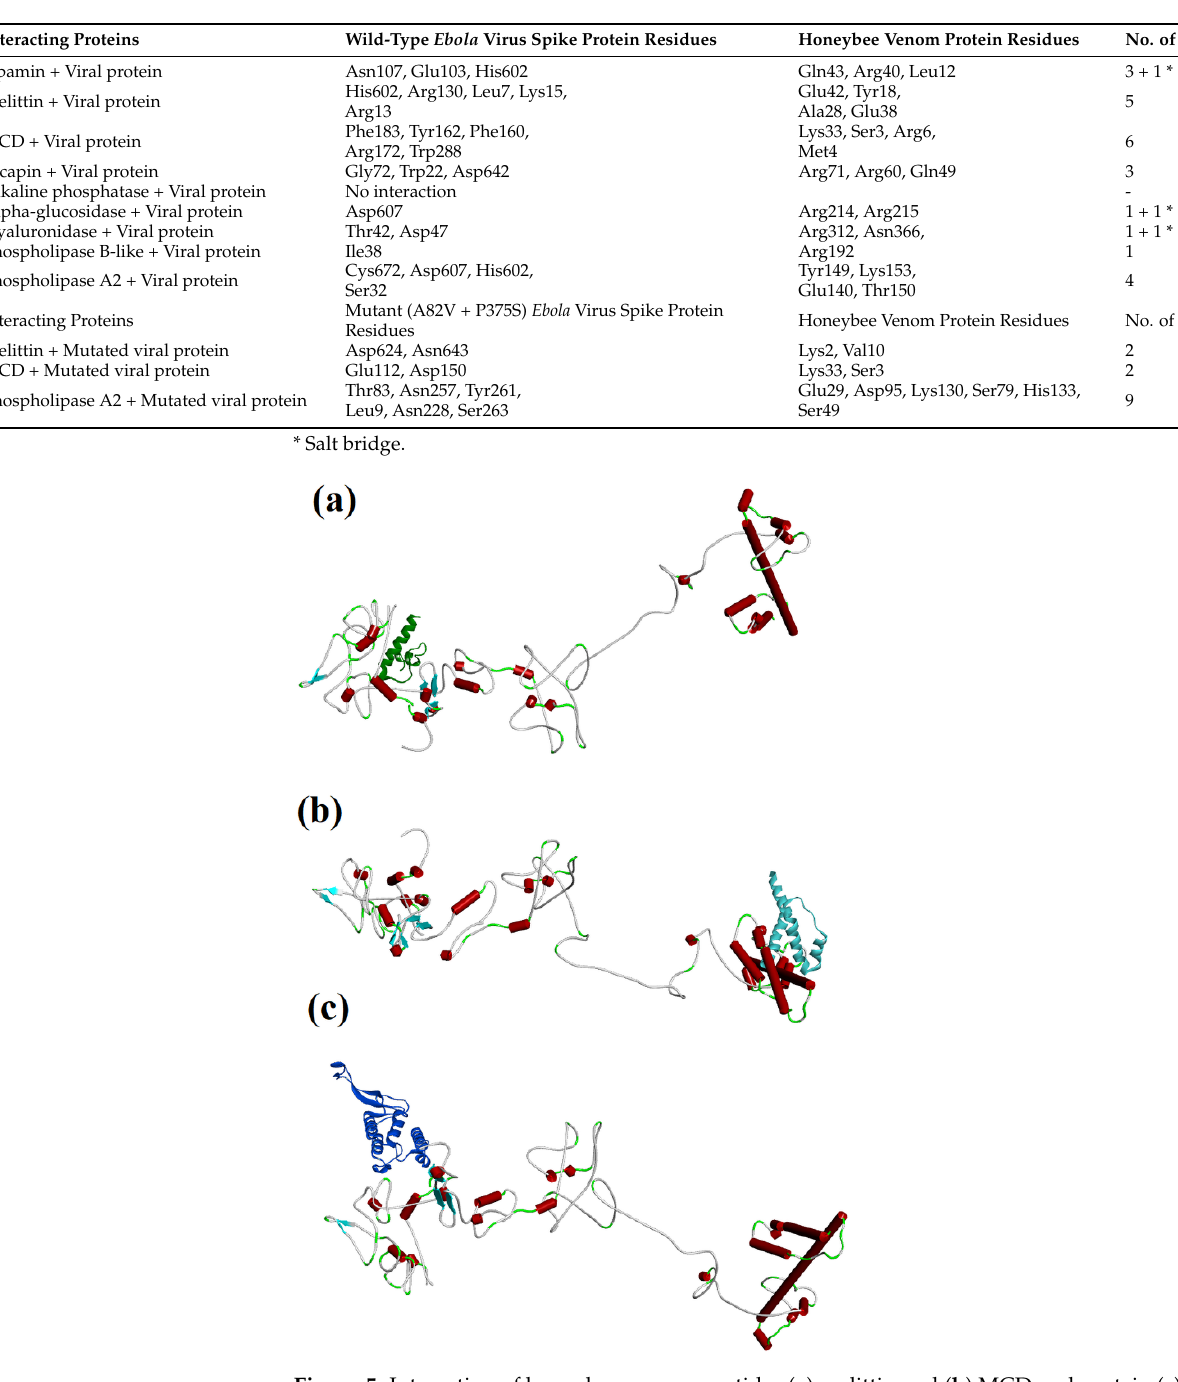
Table 1. Name and number of interacting residues between honeybee venom peptides and proteins and Ebola virus spike protein.